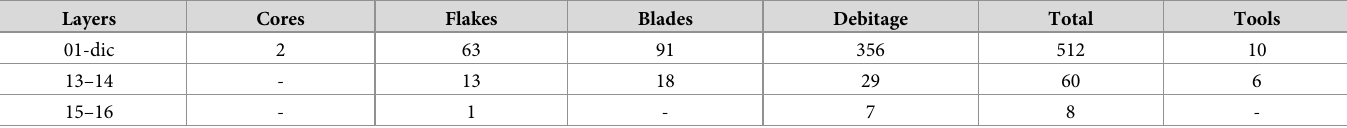
Table 3. Lithic assemblages found in zone 2. Layer 1–12 are mixed layers mainly from Holocene context. Layers 13–14 are dated to the Upper Palaeolithic and could rep- resent Solutrean remains. Layers 15–16 were sealed by a flowstone layer and date to the Gravettian. Layers